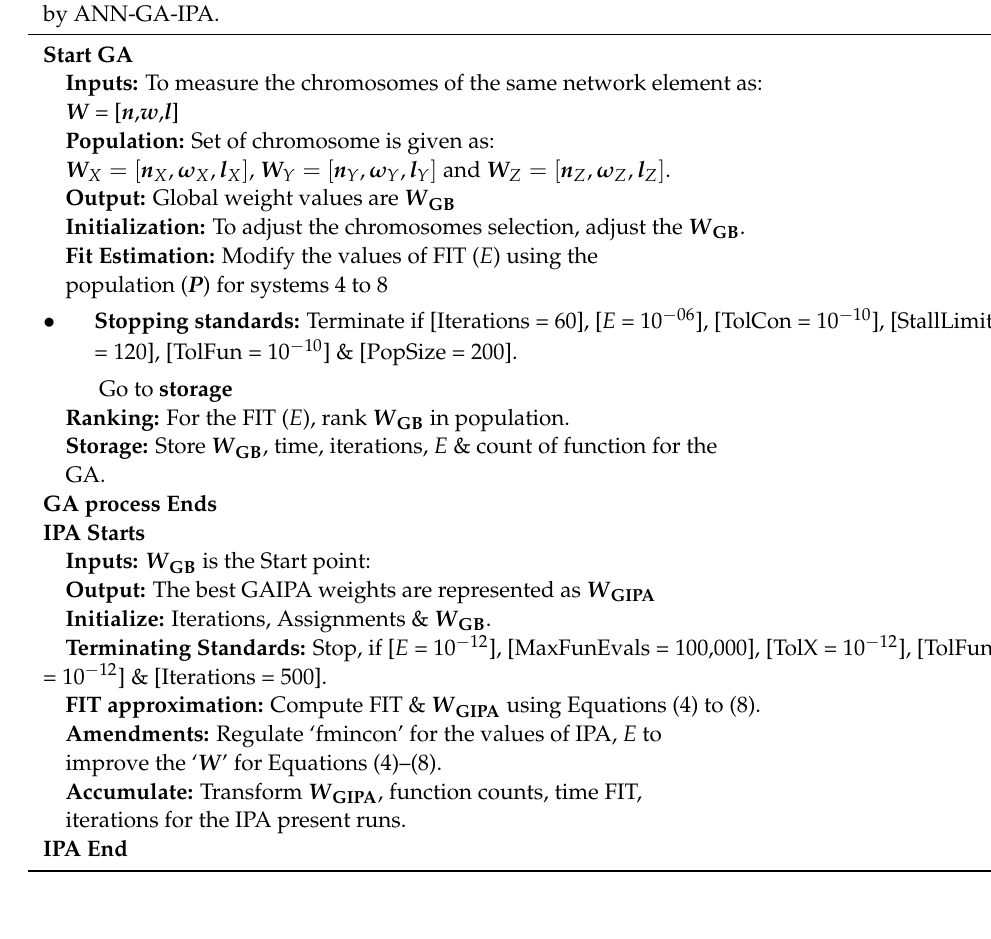
Algorithm 1. Pseudo code for optimization for the environmental and economic nonlinear